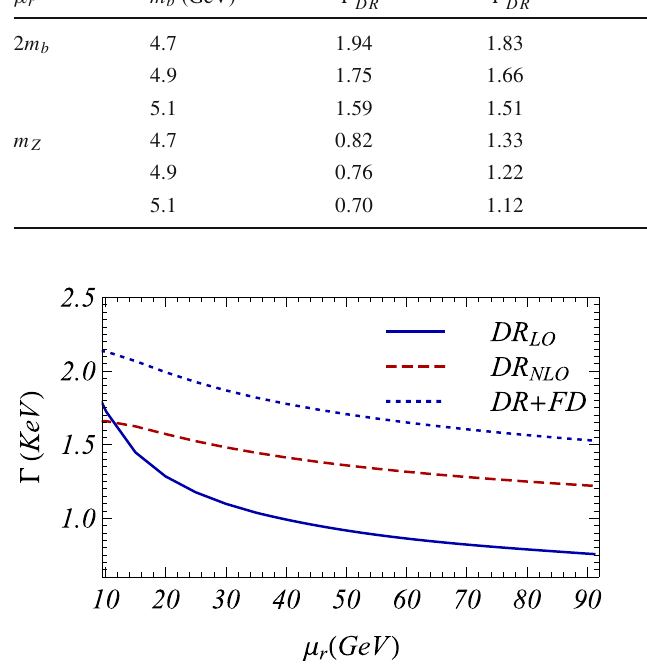
Fig. 4 The total decay widths of Z → ϒ( 1 S ) + g + g as a function of the renormalization scale μ r with m b = 4 . 9 GeV. “NLO” represents the sum of the contribution of the LO terms and that of the QCD correc- tions. The superscripts “DR” and “FD” denote the direct and feeddown contributions,